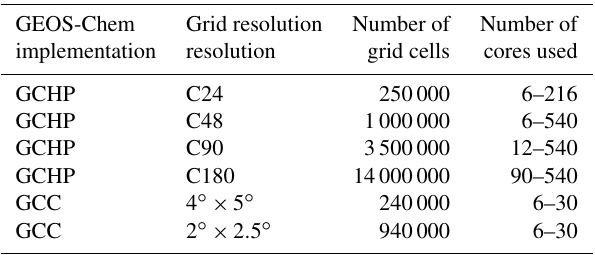
Table 1. Grid resolution and core counts for the performance test simulations. Both GCC and GCHP use v11-02c of the core GEOS- Chem code.